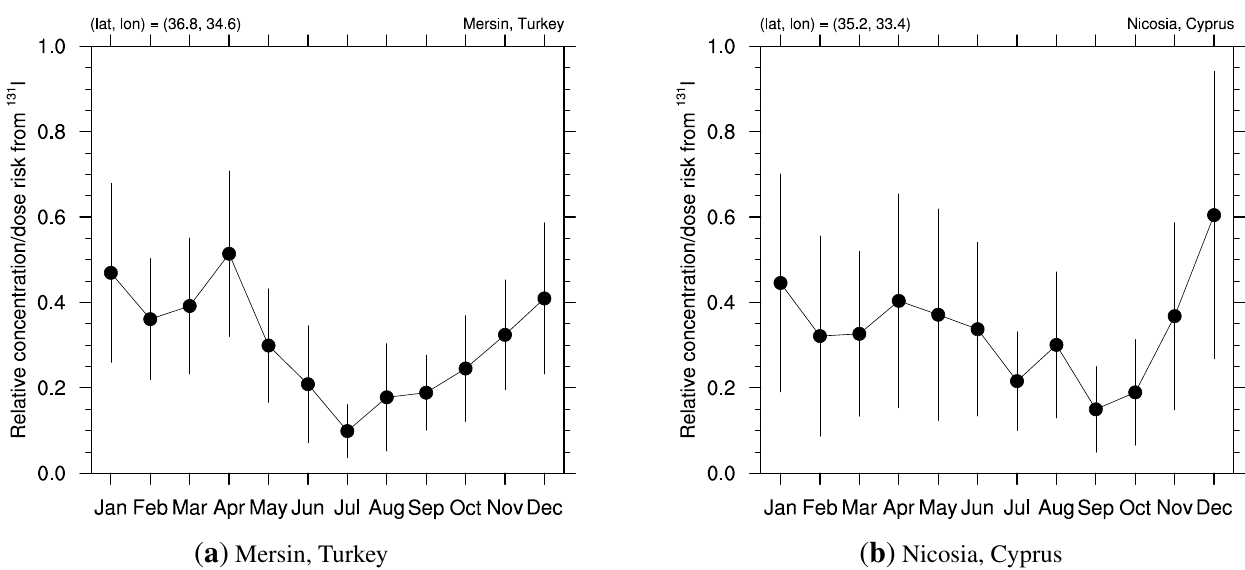
Figure 6. Monthly mean relative 131 I surface concentration and associated dose risk from a potential accident at the Akkuyu NPP for the cities of Mersin, Turkey ( a ), and Nicosia, Cyprus ( b ).